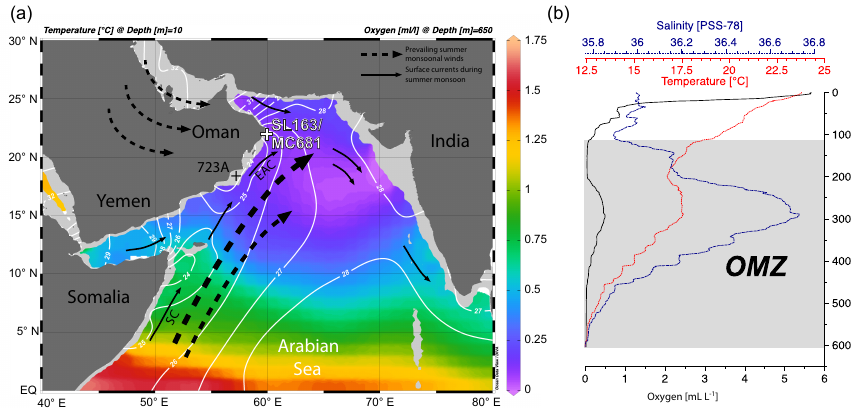
Figure 1. (a) Map of the Arabian Sea, showing the location of gravity core SL163 and multicorer MC681 (white cross) at the northern Oman margin (21 ◦ 55.97 (cid:48) N, 059 ◦ 48.15 (cid:48) E) in 650m water depth, as well as Integrated Ocean Drilling Program (IODP) core 723A (black cross) studied by Gupta et al. (2005). Black arrows show the schematic pathways of major currents (solid lines; SC is Somali Current and EAC is East Arabian Current) and near-surface winds (stippled lines) during the summer monsoon. White contour lines refer to the summer (July to September) sea surface temperature (SST) in 10m water depth. Colour shading indicates oxygen concentration (mLL − 1 ) in 650m water depth, indicating a strong oxygen deficiency in the modern depth of the sampled sediment core. SST (Locarnini et al., 2010) and oxygen concentration (Garcia et al., 2010) are from World Ocean Atlas 2009. Panel (b) shows the depth profile of oceanographic data (salinity, temperature and oxygen) measured during cruise M74/1b at the station of core SL163. Grey shading refers to the location of the modern oxygen minimum zone (OMZ). A subsurface salinity maximum in 200–400m water depth indicates the location of Persian Gulf Water (PGW). The map was created using the software ODV ver. 4.7.4 (Schlitzer,